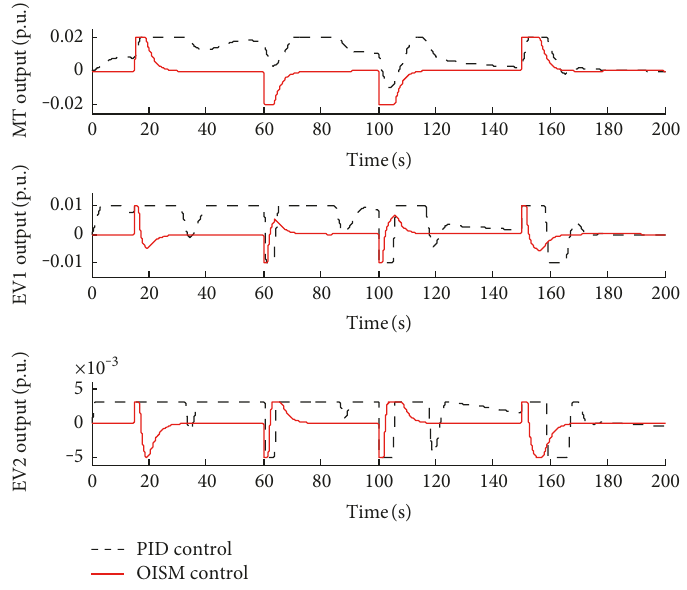
Figure 12: The frequency performance with power output constraints. Table 4: The sum of frequency